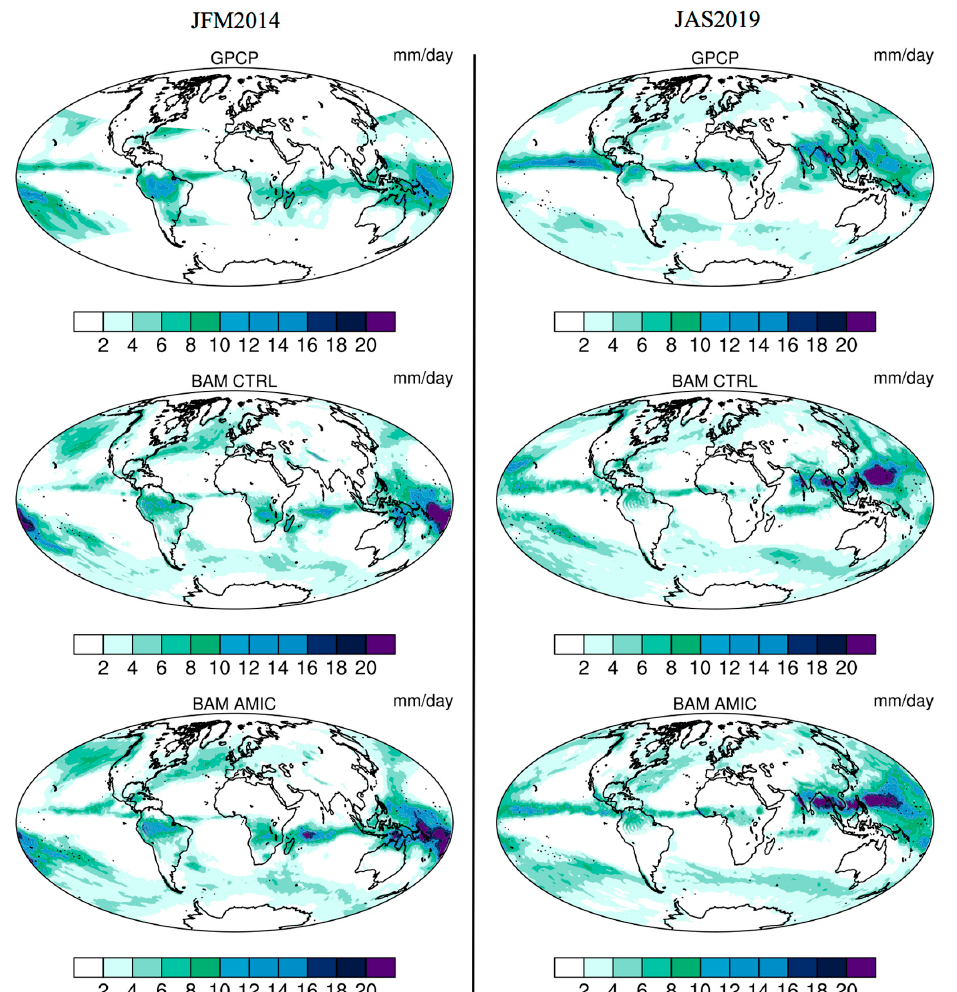
Figure 6. Model evaluation of total precipitation (mm/day) based on GPCP satellite data for simu- lations without and with aerosols in the JFM2014 (left panel) and JAS2019 (right panel) sets. Comparing the 2 m temperature simulated in BAM CTRL and BAM AMIC simula- tions, the inclusion of aerosols slightly increased the temperatures over equatorial and midlatitudes in both seasons (Supplementary Figure S5). On the contrary, 2 m specific humidity is reduced, leading to drier conditions due to the presence of aerosols.